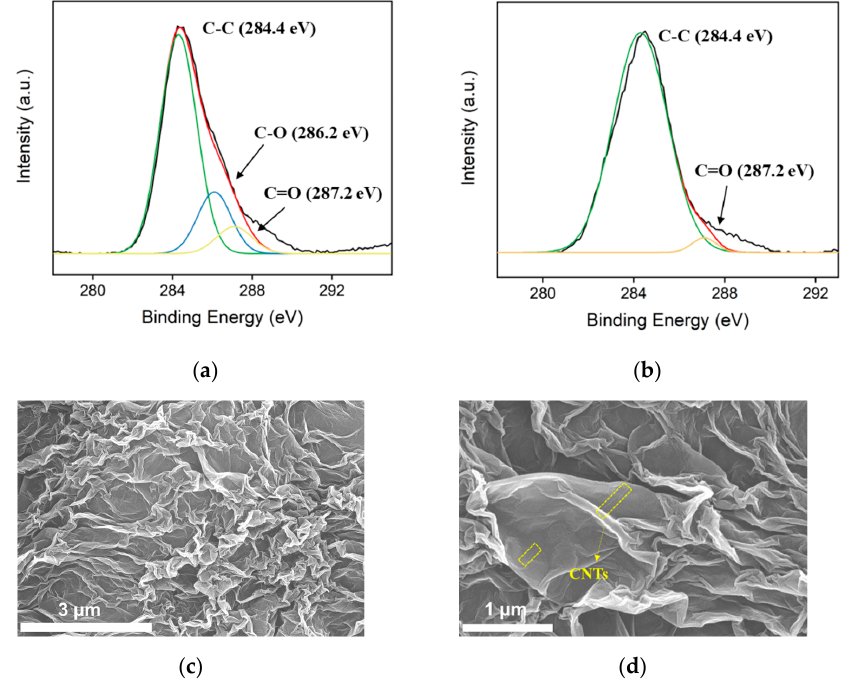
Figure 1. ( a , b ) The XPS C1s spectra of the GO ( a ) and ErGO ( b ). ( c , d ) SEM images of the 3DG-CNT network electrodeposited under a potential of − 1.2 V for 300 s.